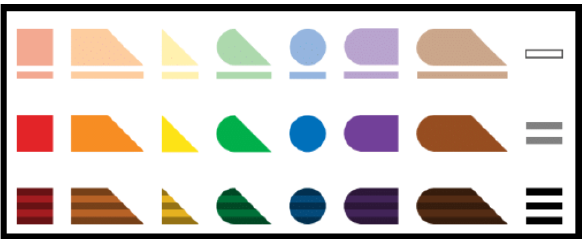
Figure 3. Feelipa color code. Source: